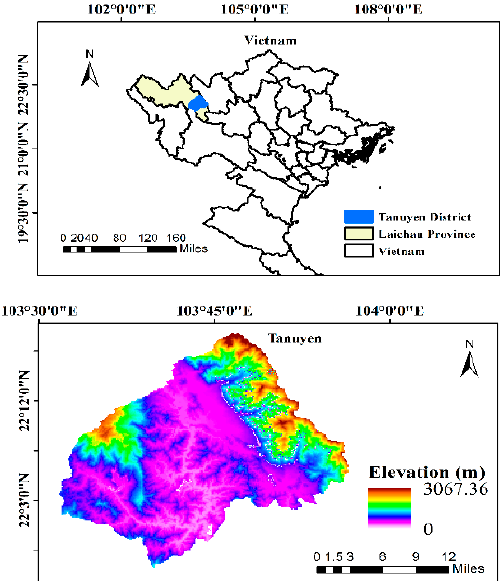
Figure 1. Location of Tanuyen District in Laichau, Vietnam.